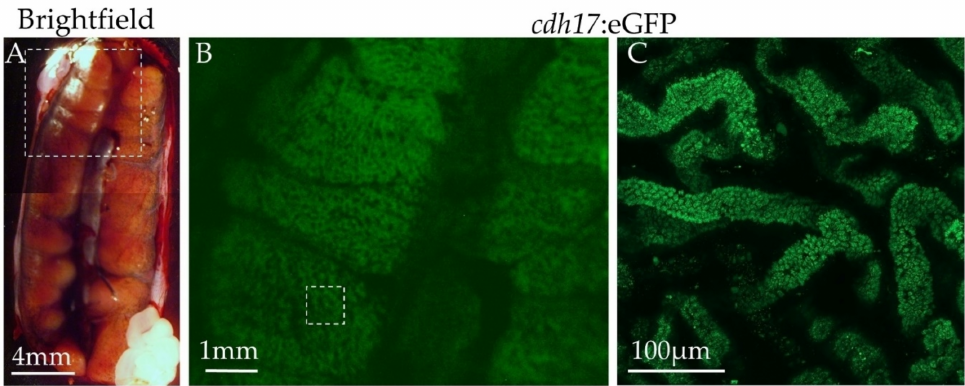
Figure 8. X. laevis adult mesonephric tubules express cdh17 :eGFP. Adult kidneys were dissected, then imaged from an F1 generation cdh17 :eGFP animal. ( A ) Brightfield image of X. laevis cdh17 :eGFP kidney. ( B , C ) GFP fluorescence imaging of cdh17 :eGFP kidney. Dashed boxes indicate regions taken for fluorescence